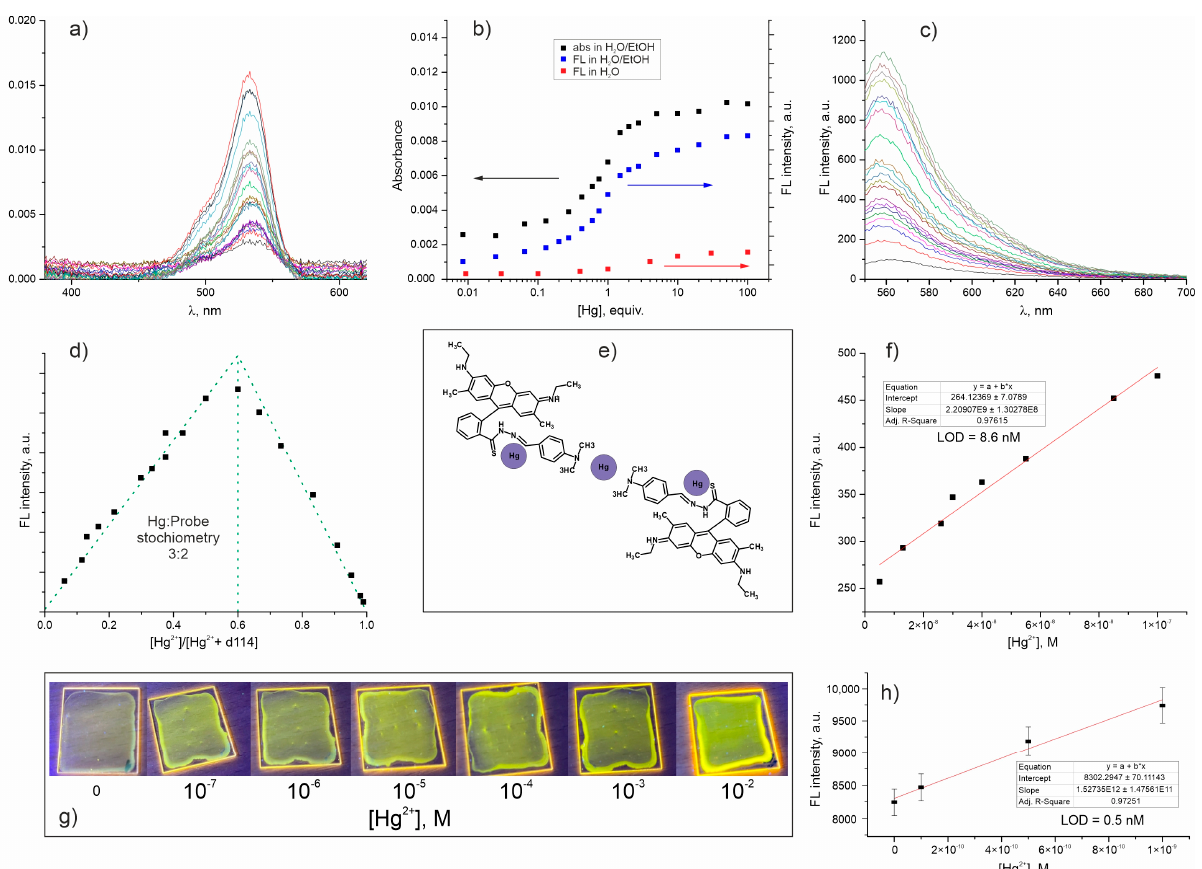
Figure 2. Characterization of d114 probe in H 2 O/C 2 H 5 OH (1/1, v / v ): the change of absorbance ( a , b ) and fluorescence ( c , b ) spectra upon successive addition of Hg 2+ to d114 solution with concentration of 10 − 6 M; Job’s plots (method of continuous variation) showing formation of 3:2 Hg 2+ /d114 complexes in solution ( d ); proposed binding scheme between d114 and Hg 2+ ions ( e ); dependence of the response signal on the concentration of the analyte and results of the Hg 2+ LOD calculations ( f ). Photo of PMMA slides with latex coatings containing d114 probe immersed for 5 min in Hg 2+ solutions (pH = 6) and excited with 365 nm LED ( g ); and results of the Hg 2+ LOD calculations for d114-doped coating ( h ).